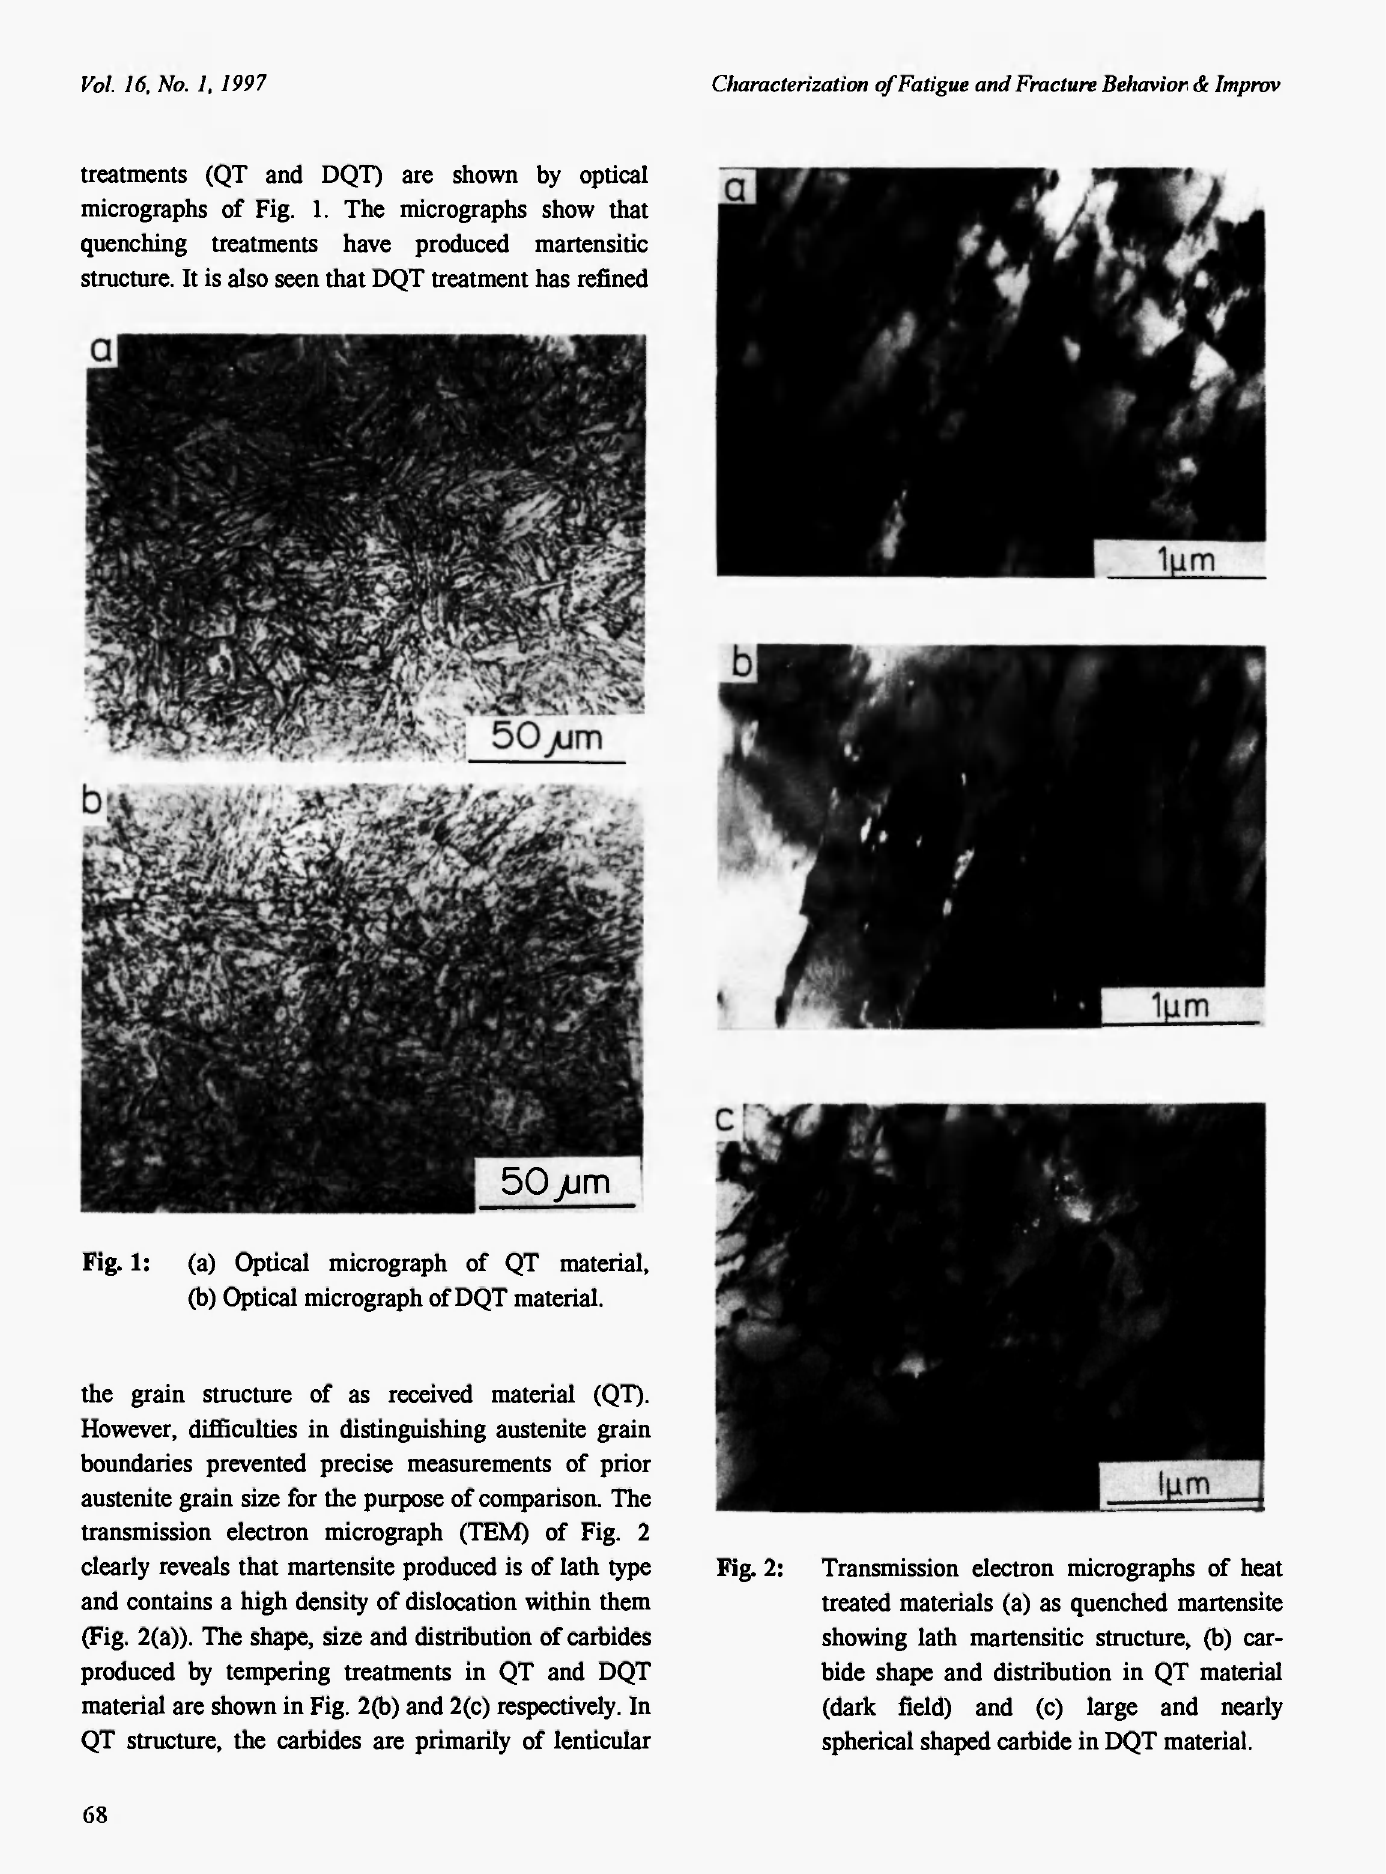
Fig. 1: (a) Optical micrograph of QT material, (b) Optical micrograph of DQT